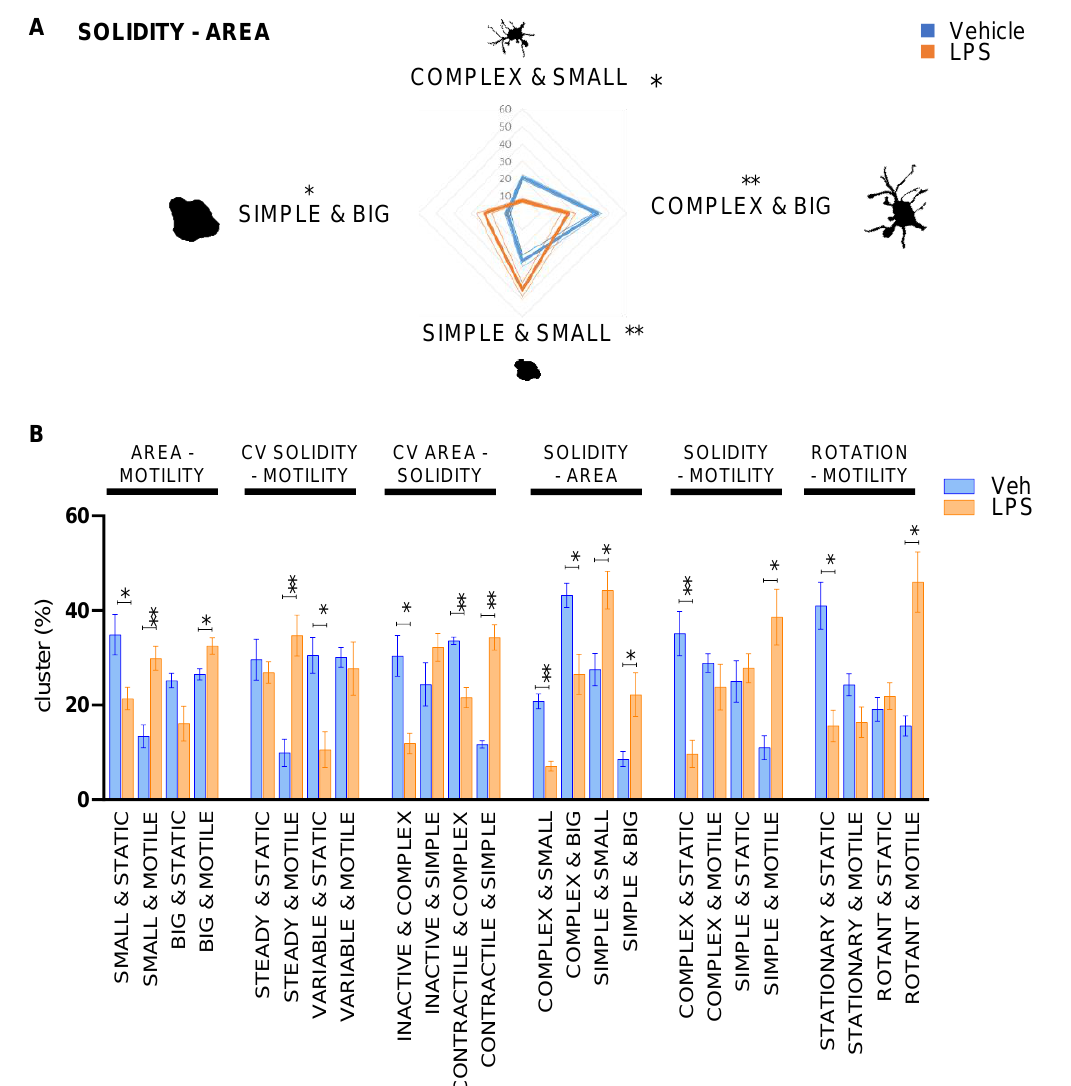
Figure 2. Morpho-functional biparametric analysis of LPS-treated male microglia. ( A ) Biparametric analysis of microglial solidity and area allows to cluster the cells into four categories: “complex & big”, “complex & small”, “simple & small”, and “simple & big”. The percentage of each population is reported as a radar graph relative to three independent experiments. Drawings represent the morphology representative of the category. * p < 0.05, and ** p < 0.01; calculated by t -test versus vehicle. ( B ) Biparametric analysis represented as histogram of the median ± SEM of the subpopulation percentage obtained in 3 different experiments; the two parameters obtained to generate the clusters are reported on the top of the graph. * p < 0.05, and ** p < 0.01 calculated by t -test versus vehicle.